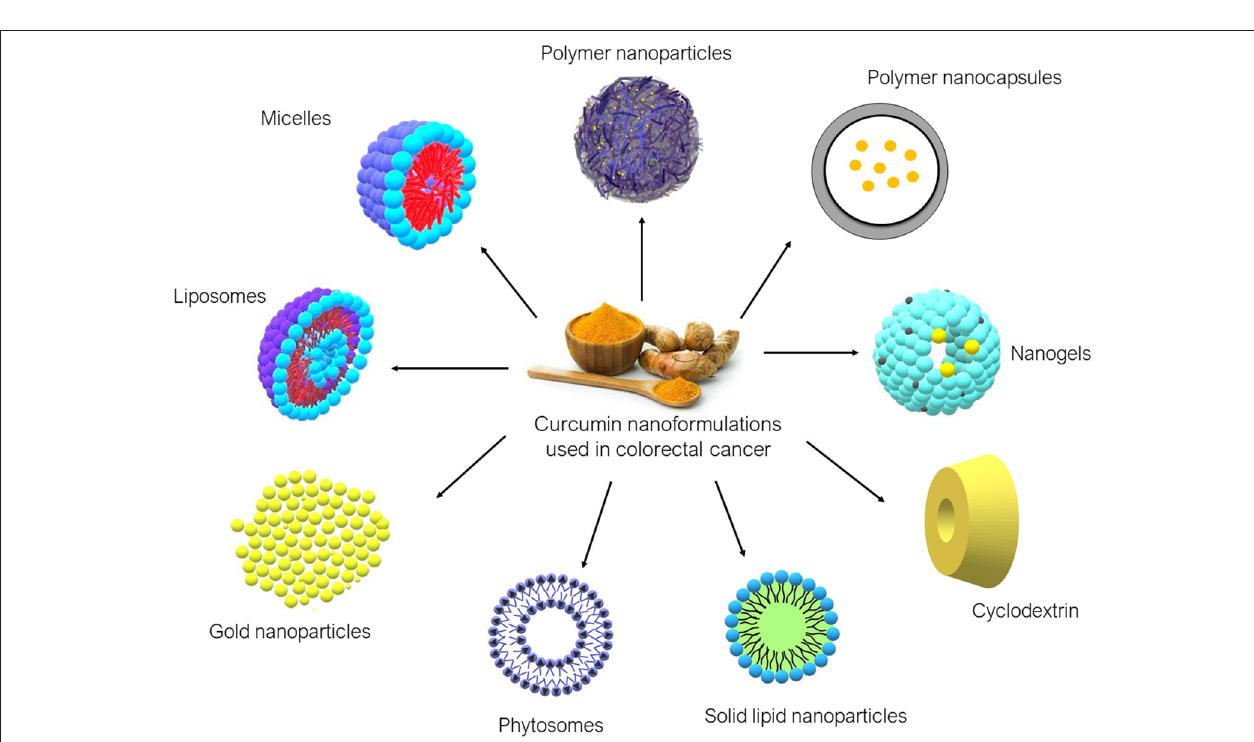
FIGURE 3 | Curcumin nanoformulations used in colorectal cancer found in the literature.